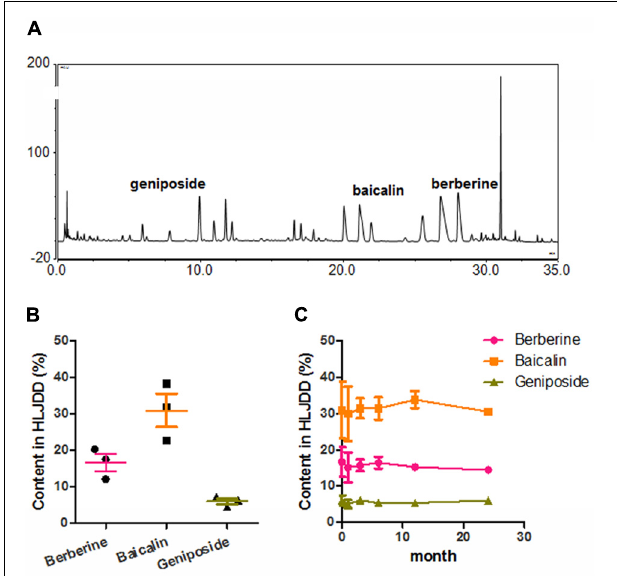
FIGURE 1 | Quality control of HLJDD. (A) Showed the representative chromatogram of HLJDD extracts. Three major compounds, berberine, baicalin and geniposide, were identified on the chromatogram by matching the retention time and UV spectrum with those of reference compounds; (B) showed the inter-batches quality of HLJDD as represented by the relative contents of berberine, baicalin and geniposide; (C) showed that stability of HLJDD over 24-month storage as represented by the relative contents of berberine, baicalin, and